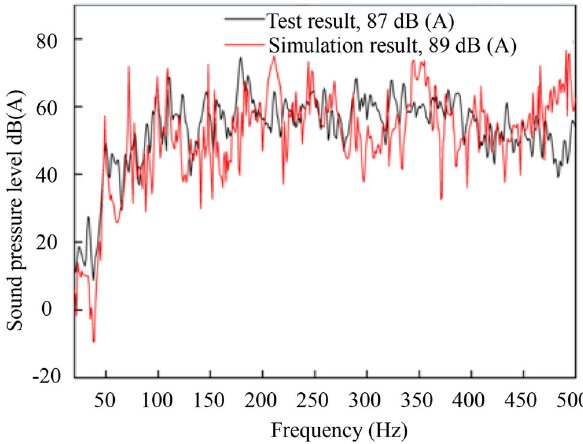
Fig. 12 A-weighted sound pressure level at N02 of test and